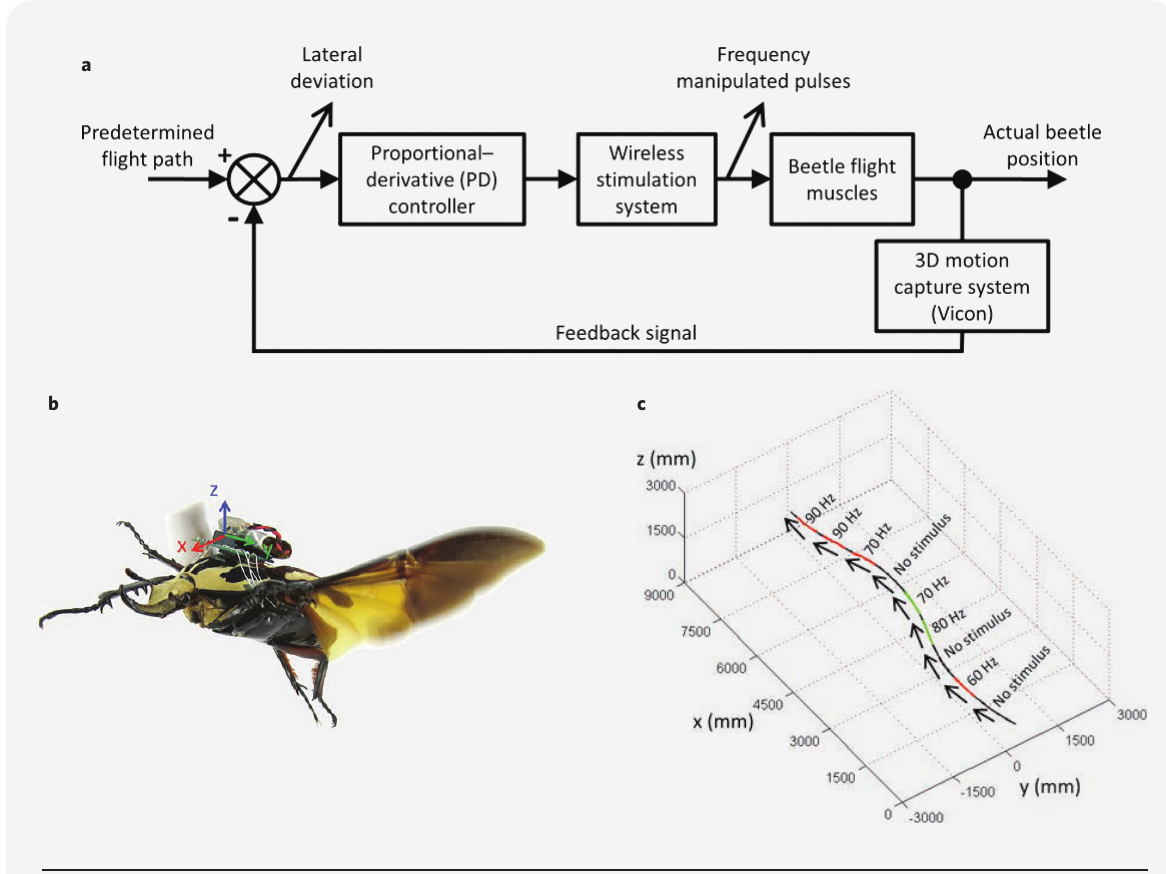
Figure 6. Feedback fl ight control for insect–computer hybrid fl ying robot. (a) Schematic of the feedback control system. The system reads the real- time position of the fl ying beetle as feedback information and modulates the stimulation frequencies based on the positional deviations. (b) Wireless backpack mounted on a fl ying beetle for muscular stimulation. In total, eight wires were soldered onto the output ports of the backpack. The terminals of the wires were inserted into four fl ight muscles: the basalar muscles and the third axillary muscles. (c) The fl ight of the beetle was modulated by the feedback control system. The output frequencies were generated according to the real-time fl ight status of the beetle. The segments in green and red denote the trajectories during left and right stimulation,